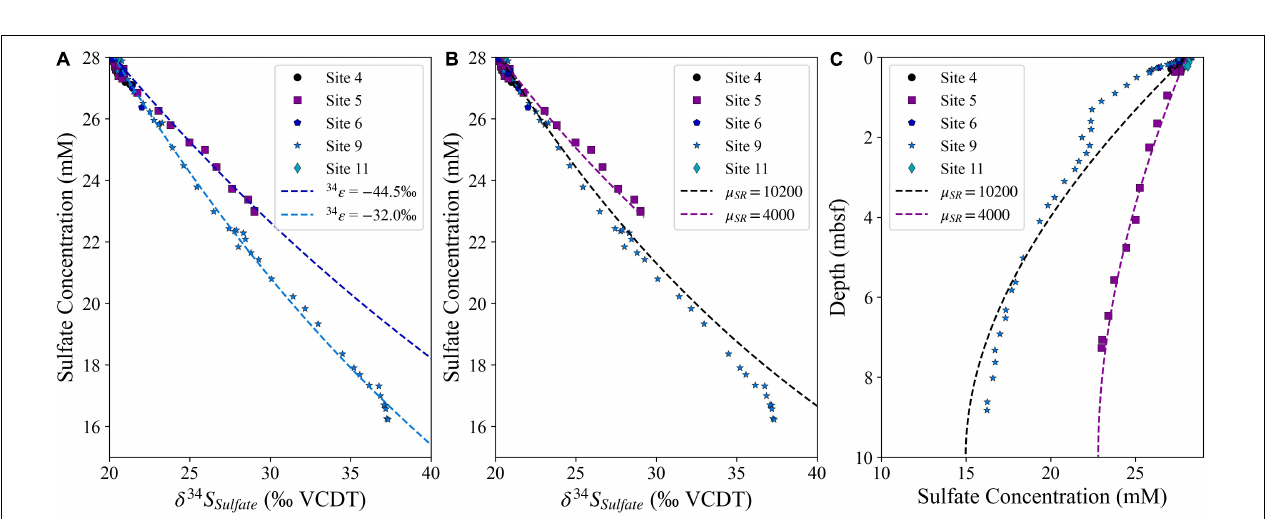
(dashed lines) (cid:104) (cid:104)